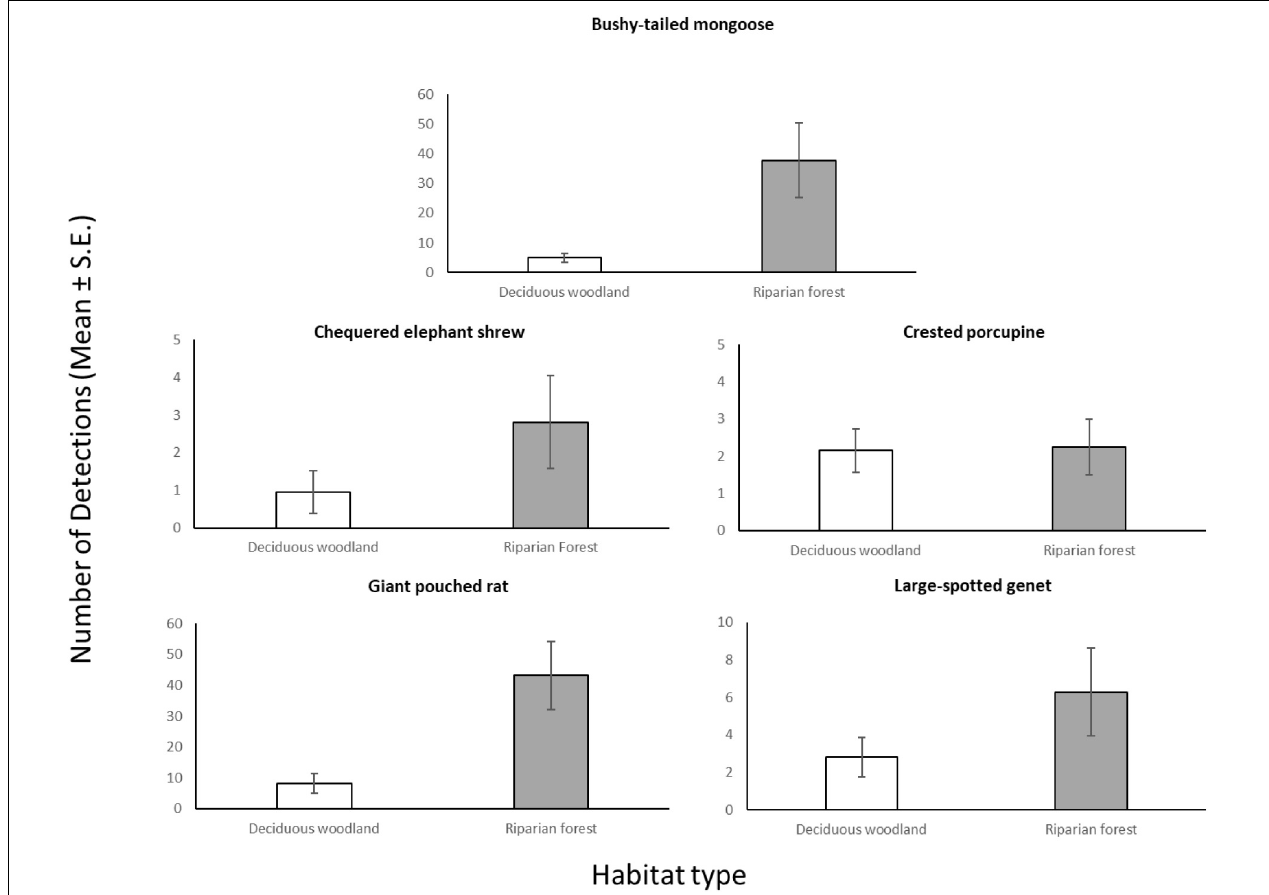
FIGURE 2 | Average number of camera days (Mean ± S.E.) in which each meso-mammal species in Issa Valley was detected, compared between CT sites in deciduous woodland (n = 20) and riparian forest ( n =